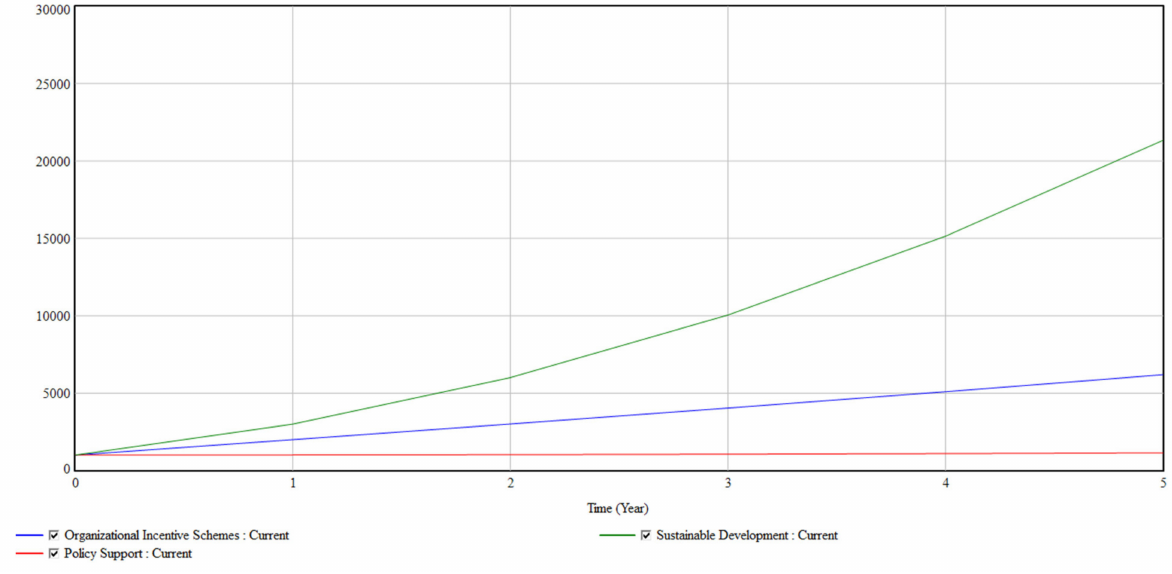
Figure 15. Combined Simulation